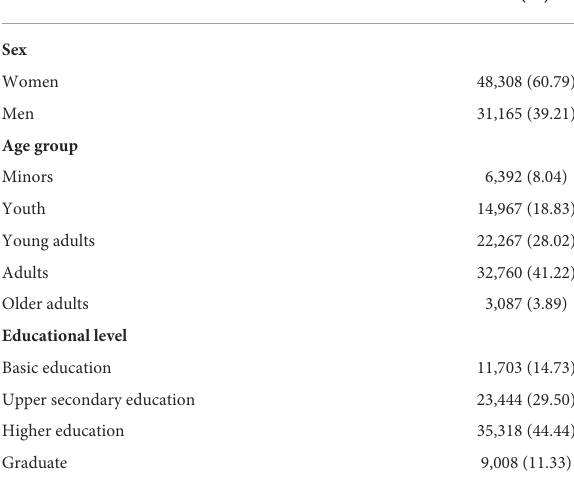
TABLE 2 Factor loads of GAD-5 items.